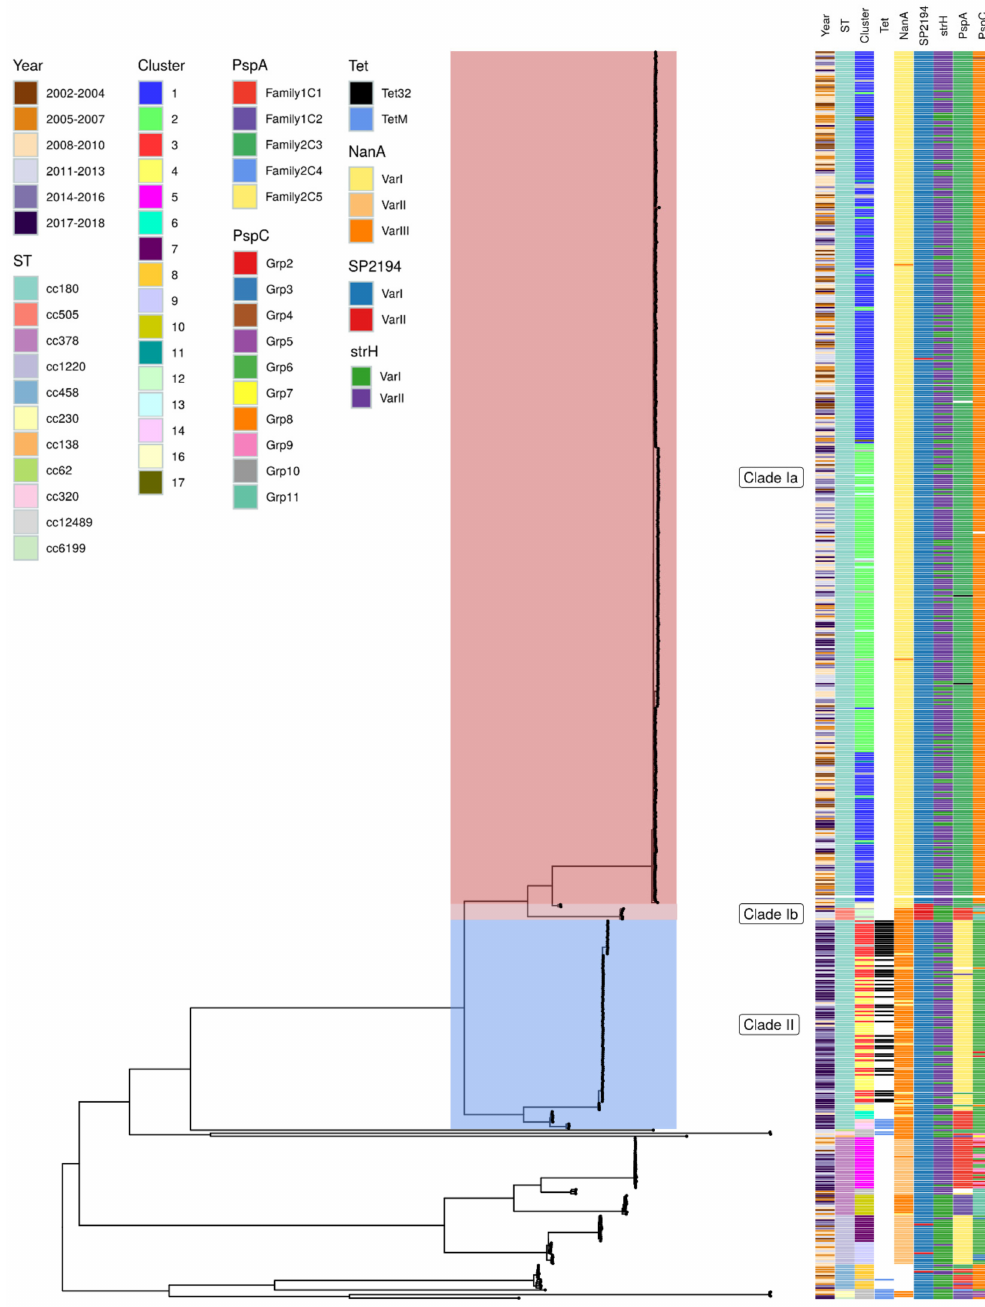
Figure 4. Maximum likelihood tree of all S. pneumoniae PHE-serotyped genomes that met the minimum QC requirements (see methods). The tree is midpoint rooted. Clades Ia (red), Ib (light pink) and II (blue) are indicated on the corresponding clades and labelled. Isolates that are not highlighted are referred to as “external”. The matrix to the right of the tree shows associated metadata including the year of sampling, sequence type (ST), PopPUNK cluster, tetracycline resistance markers, and relevant protein antigen variants. Undetected genes are shown in white and protein antigen results that did meet required QC parameters are shown in